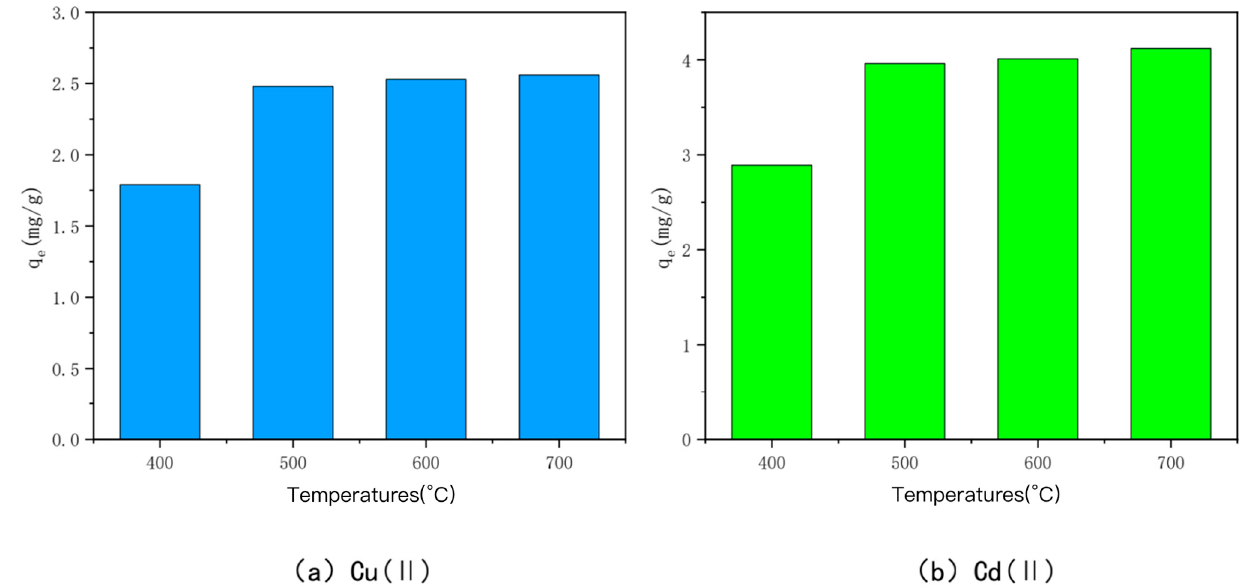
Figure 1. The adsorption capacity of Cu(II)/Cd(II) adsorbed by bamboo charcoal at different carbonization temperatures.